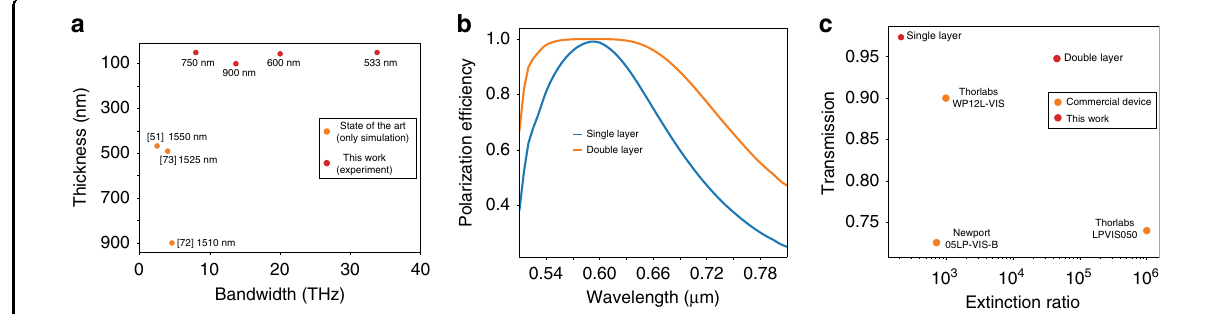
Fig. 4 Comparison with state-of-the-art and cascaded systems. a Comparison of the fabricated polarizer bandwidths with the state-of-the-art bandwidths. b Polarization ef fi ciency as a function of the number of cascaded polarizers. c Comparison of the fabricated polarizer transmission and extinction ratio with those of commercially available bulk polarizer